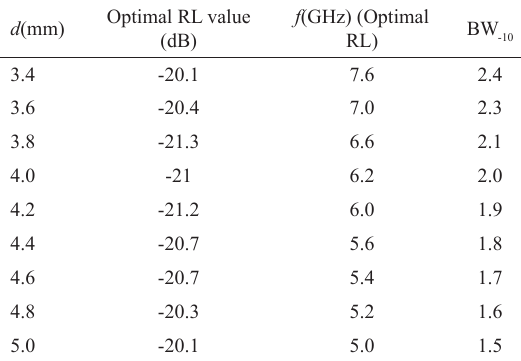
Table 1: EM-wave absorption properties of nanocapsules with different thickness. Optimal RL value d (mm)